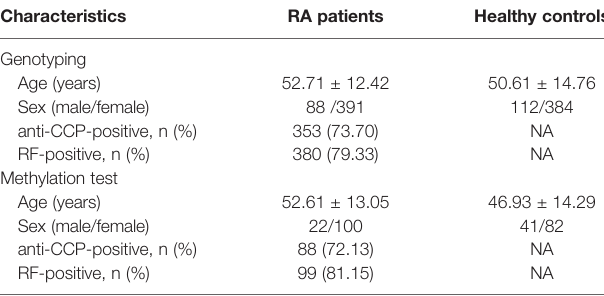
TABLE 1 | The demographic and clinical characteristics of RA patients and healthy